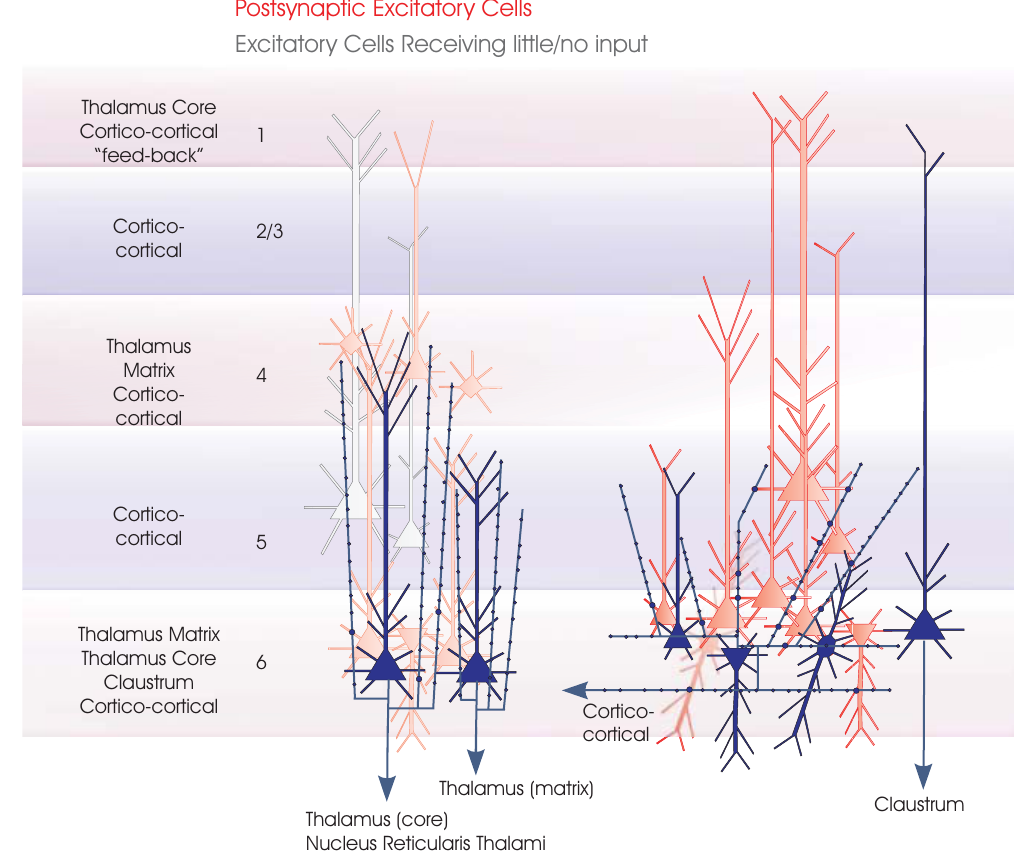
Figure 1. Layer 6 pyramidal cells . The major subclasses of layer 6 pyramidal cells are summarized in this cartoon (blue). On the left are the two types of CT pyramids projecting to different regions of the thalamus. Both are upright pyramids with apical dendritic tufts and narrow, vertically projecting axonal arbours in layer 4 and upper layer 5, respectively. Three dendritic arbours typical of CC pyramidal cells, short upright, inverted and bipolar, are shown and a claustrum projecting cell (far right). Only one horizontally oriented axonal arbour confined to the deep layers is indicated for simplicity, since all CC cells and claustrum projecting cells appear to have similar axonal arbours. The major longer distance inputs to the 6 layers are indicated to the left. Spiny, excitatory postsynaptic targets that have been demonstrated for each group of layer 6 cells with paired intracellular recordings are shown in red, the paler cells being those that receive sparse and weak inputs and the white cells those that have been tested but not to date shown to be significant targets for these layer 6 pyramidal axons